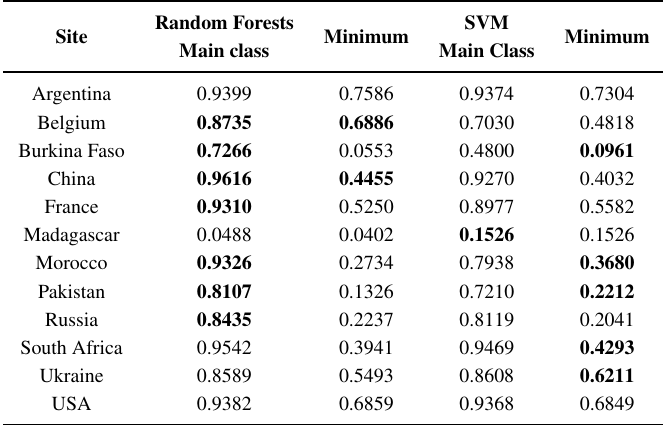
Table 2. Results for random forests and SVM. F-score of the main class and minimum F-score of all classes. Bold typeface is used to highlight statistically-significant differences between the two